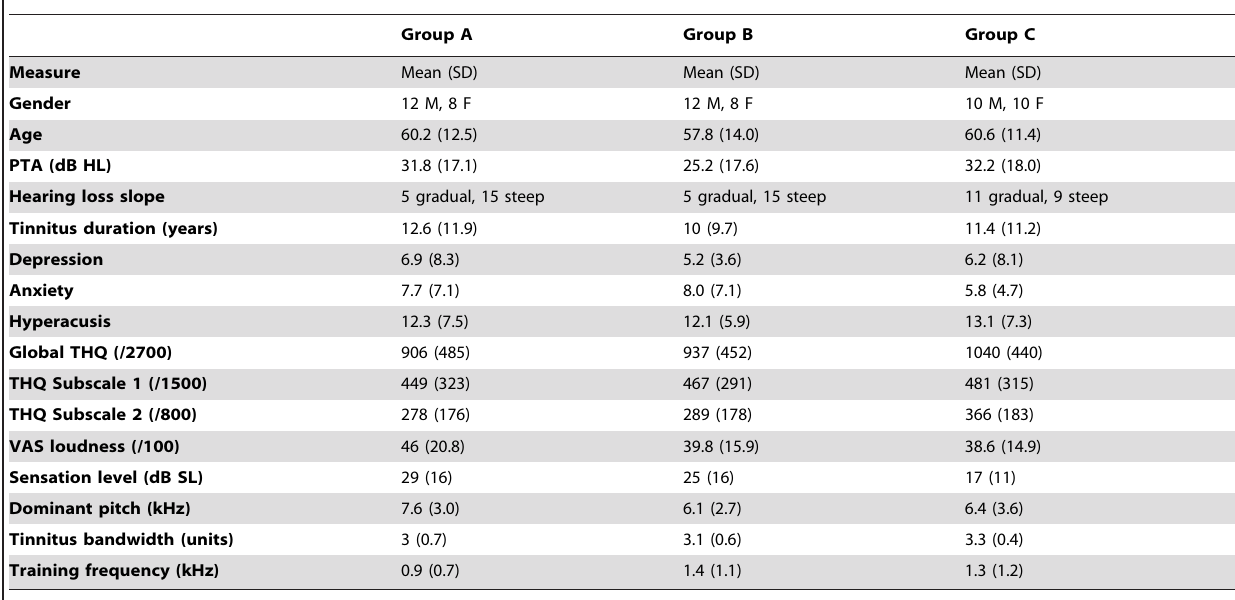
Table 1. Baseline characteristics and training